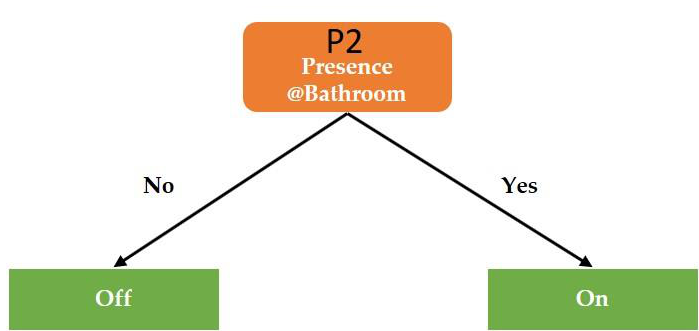
Figure 12. Decision tree for Bathroom Odor extractor over Period 2.